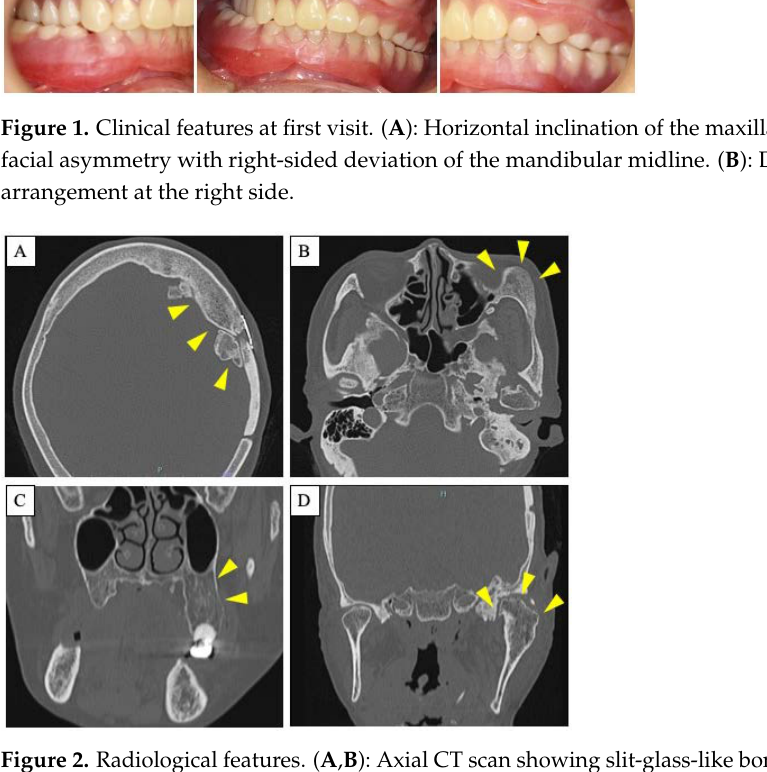
Figure 2. Radiological features. ( A , B ): Axial CT scan showing slit-glass-like bone thickening from the left temporal area to the base of the skull ( A ) and zygomatic bone ( B ). Arrowheads indicate the site of the lesion. ( C , D ): Coronal CT scan showing bone proliferation in the left alveolar region on the maxilla ( C ) and enlargement of the left articular head on the mandible ( D ). Arrowheads indicate the site of the